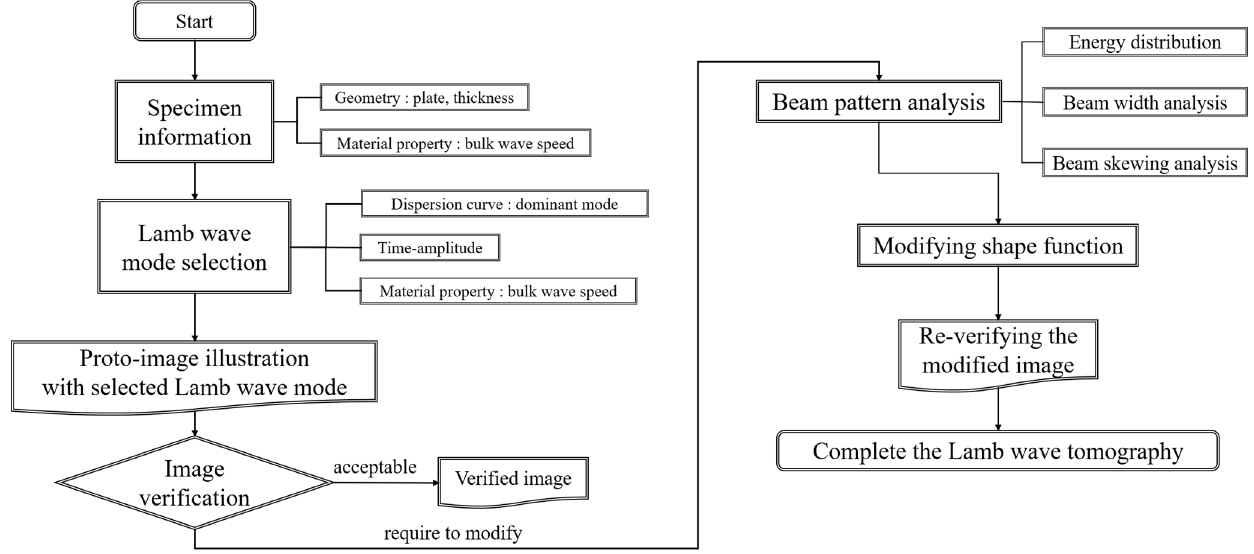
Figure 3. Overall processing of the shape function modification by using the RAPID algorithm.